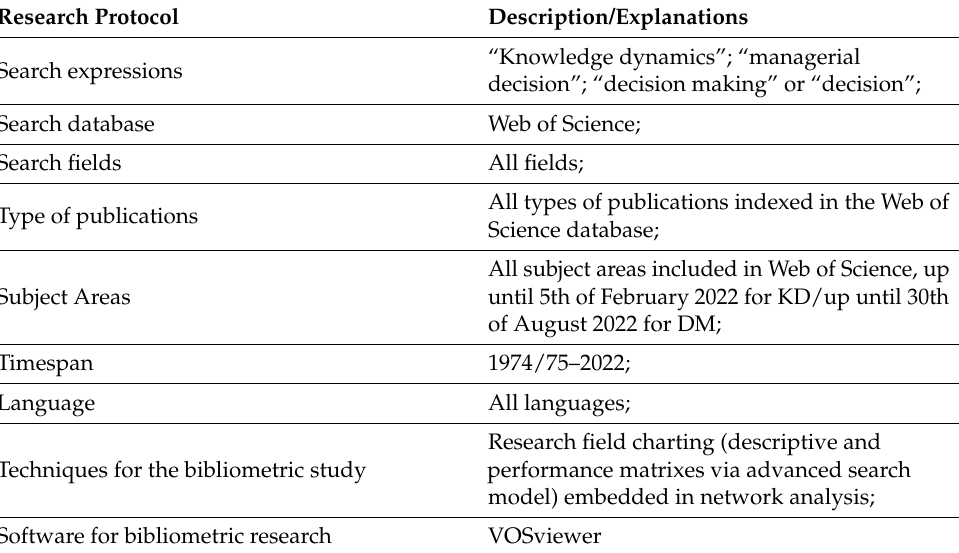
Table 3. Research protocol and characteristics and types of KD and MD research samples (Source: authors’ own research) .